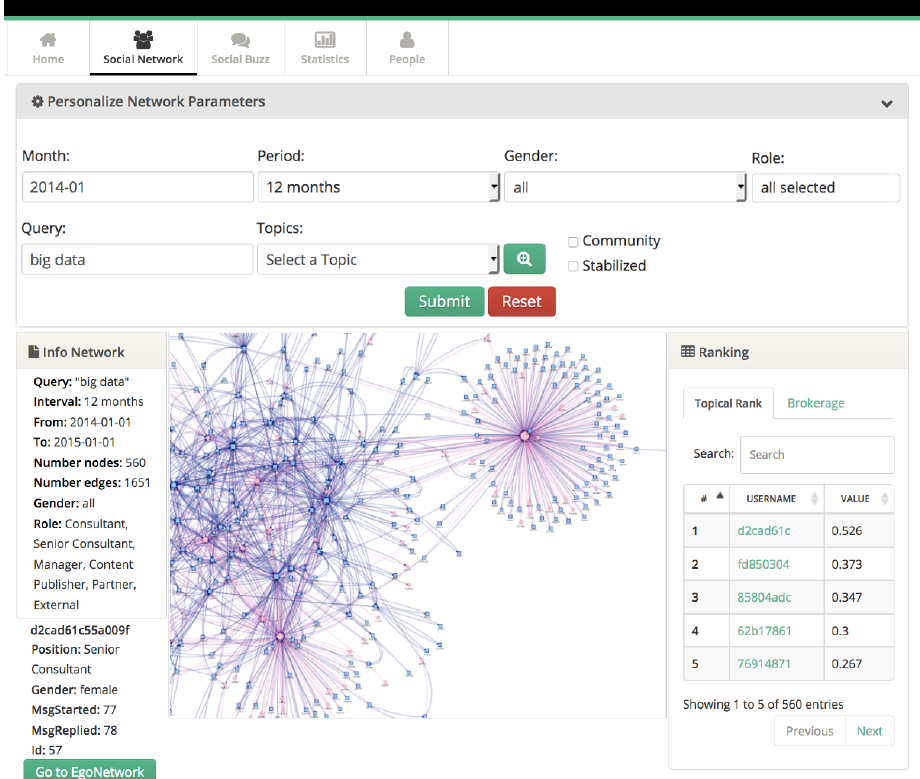
Figure 5. Topic network for the keyword “ big data ” during 2014. In this network, the top network leader was a female consultant.